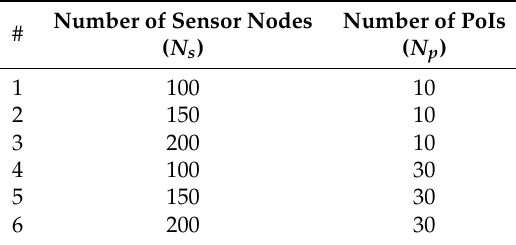
Table 1. Scenarios for the first